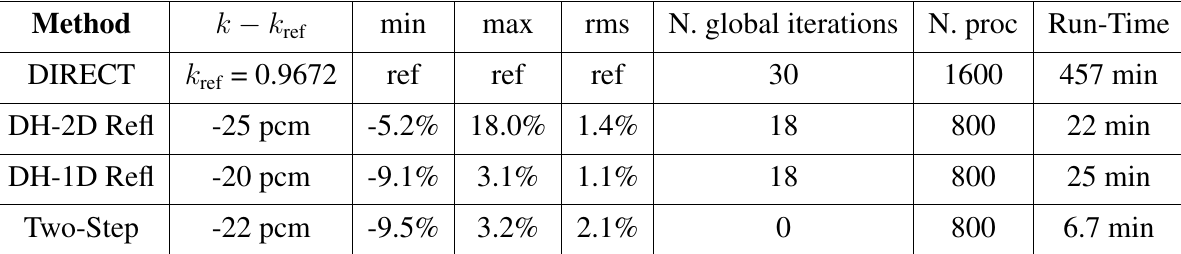
Table 1: Comparison of Two-Step and DH methods against